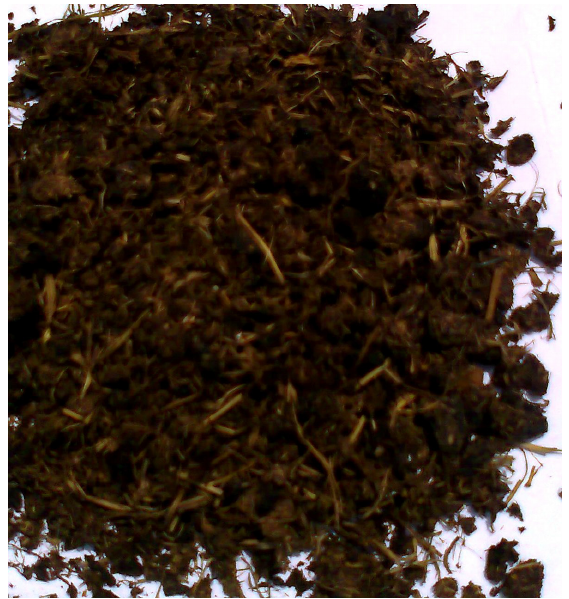
Figure A1. Bovine blood and rumen digesta mixture (BBRDM) used as organic fertilizer for cultivation of